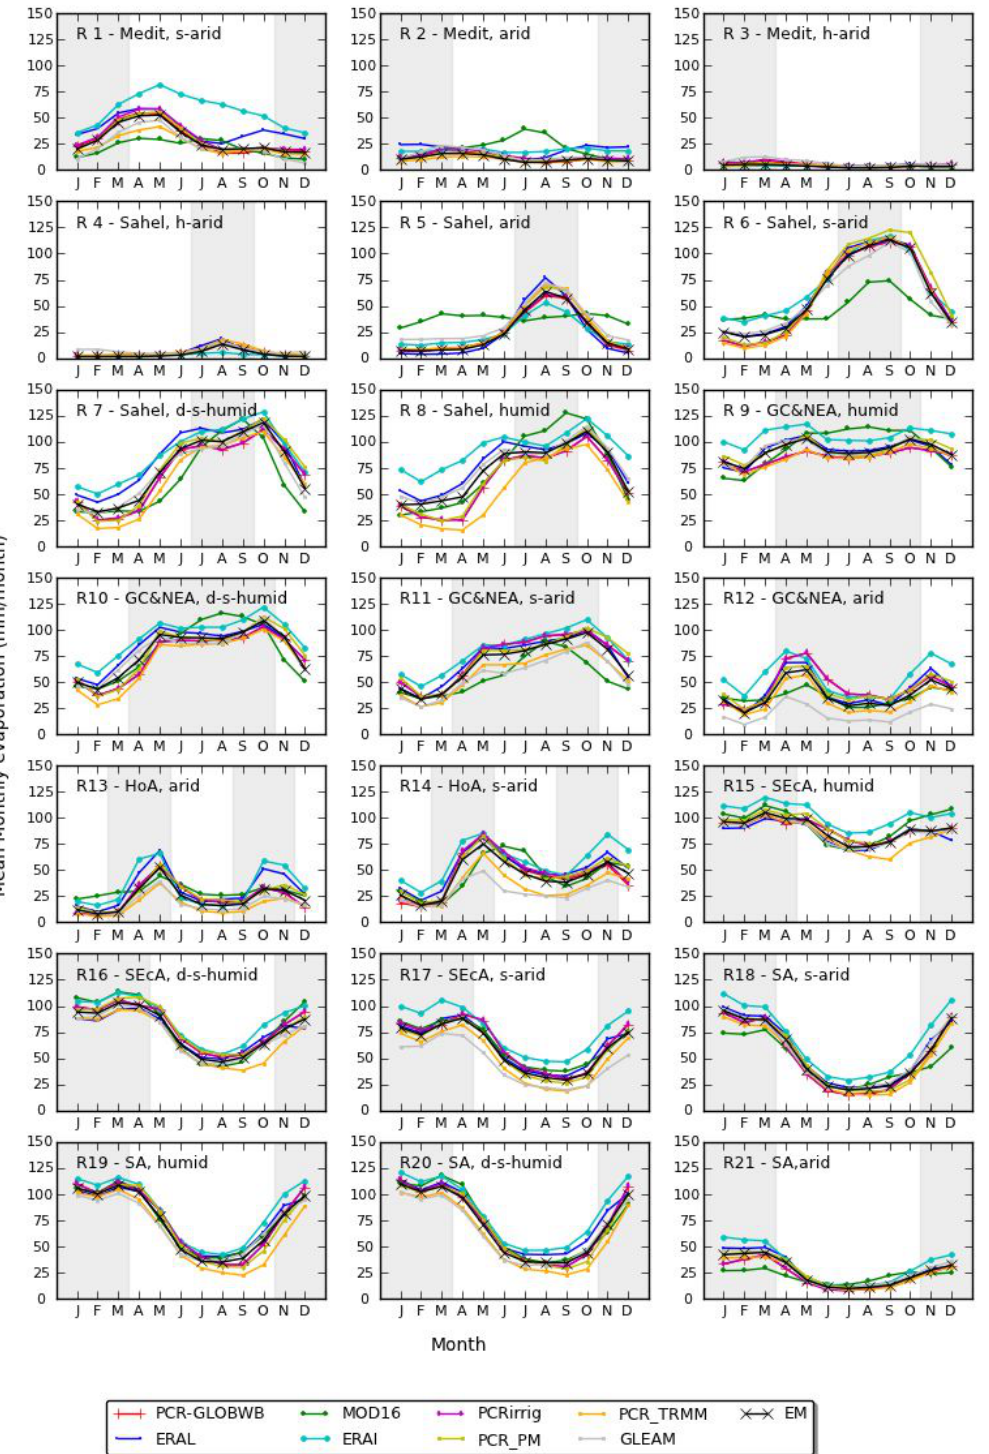
Fig. 7. Variation of mean monthly actual evaporation for each region. In grey, the wet periods, and in white the dry periods according to Sylla et al. (2010) and Jacovides et al. (2003). MOD16 product is not presented in hyper-arid areas (R3 and R4) plots due to unavailability of data for these